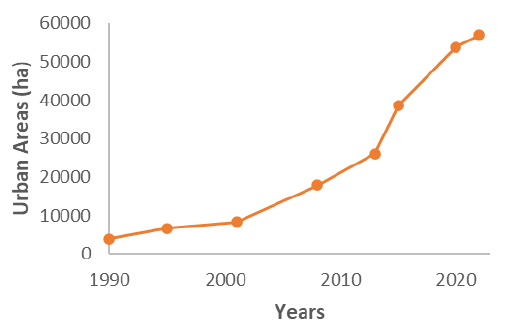
Figure 8: Growth of Urban in Abu Dhabi from 1990 to 2022. All The study area has experienced significant conversion from non-urban to urban class during the 32 years between 1990 and 2022. The change detection map created using the union matrix tool in ERDAS Imagine displays the conversions between non- urban and urban classes figure 9.